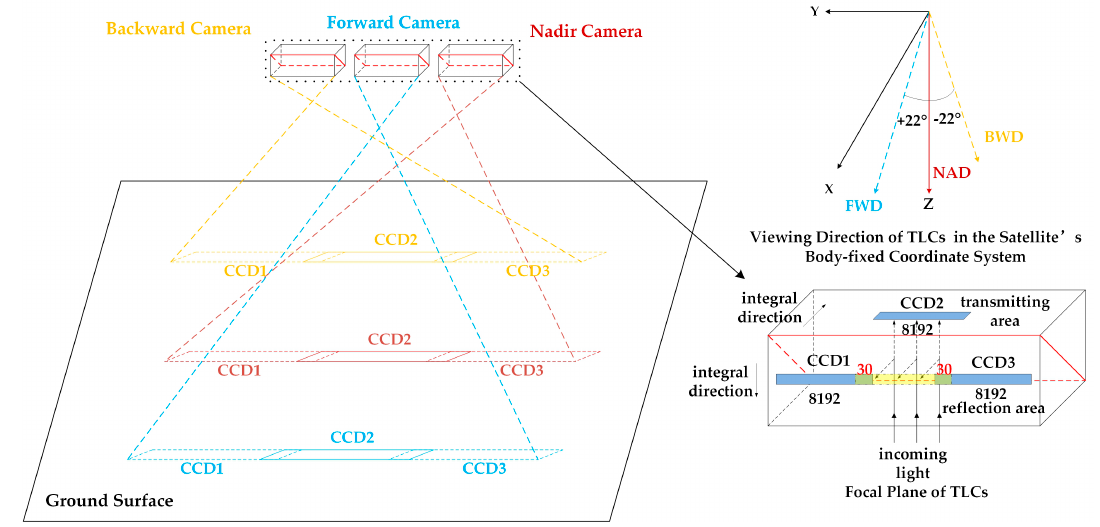
Figure 2. Schematic diagram of the stereo imaging geometry and focal plane of TLCs onboard the ZY 3-02 satellite.